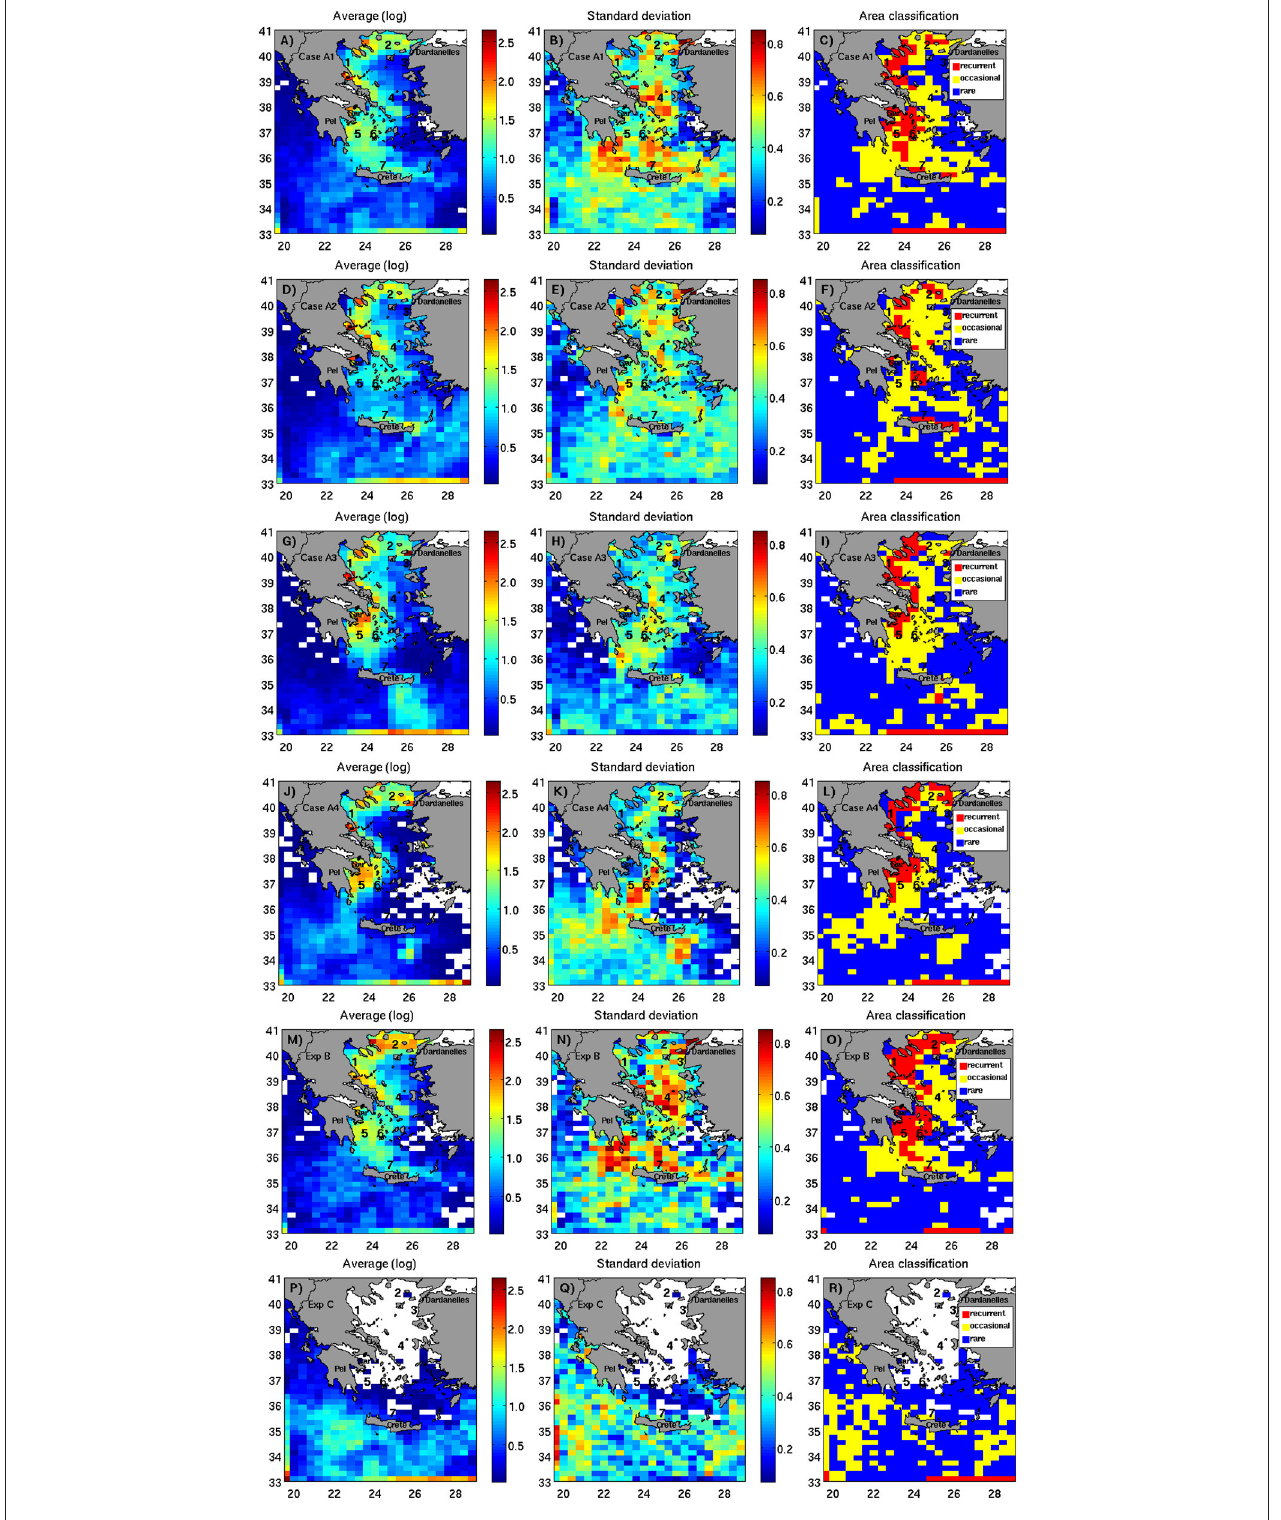
FIGURE 5 | Average, standard deviation and classification maps of floating litter distributions for Cases A1 (A–C) , A2 (D–F) , A3 (G–I) , and A4 (J–L) , Experiment B (M–O) , and Experiment C (P–R) . First row refers to Case A1, second row to Case A2, third row to Case A3, fourth row to Case A4, fifth row to Experiment B and sixth row to Experiment